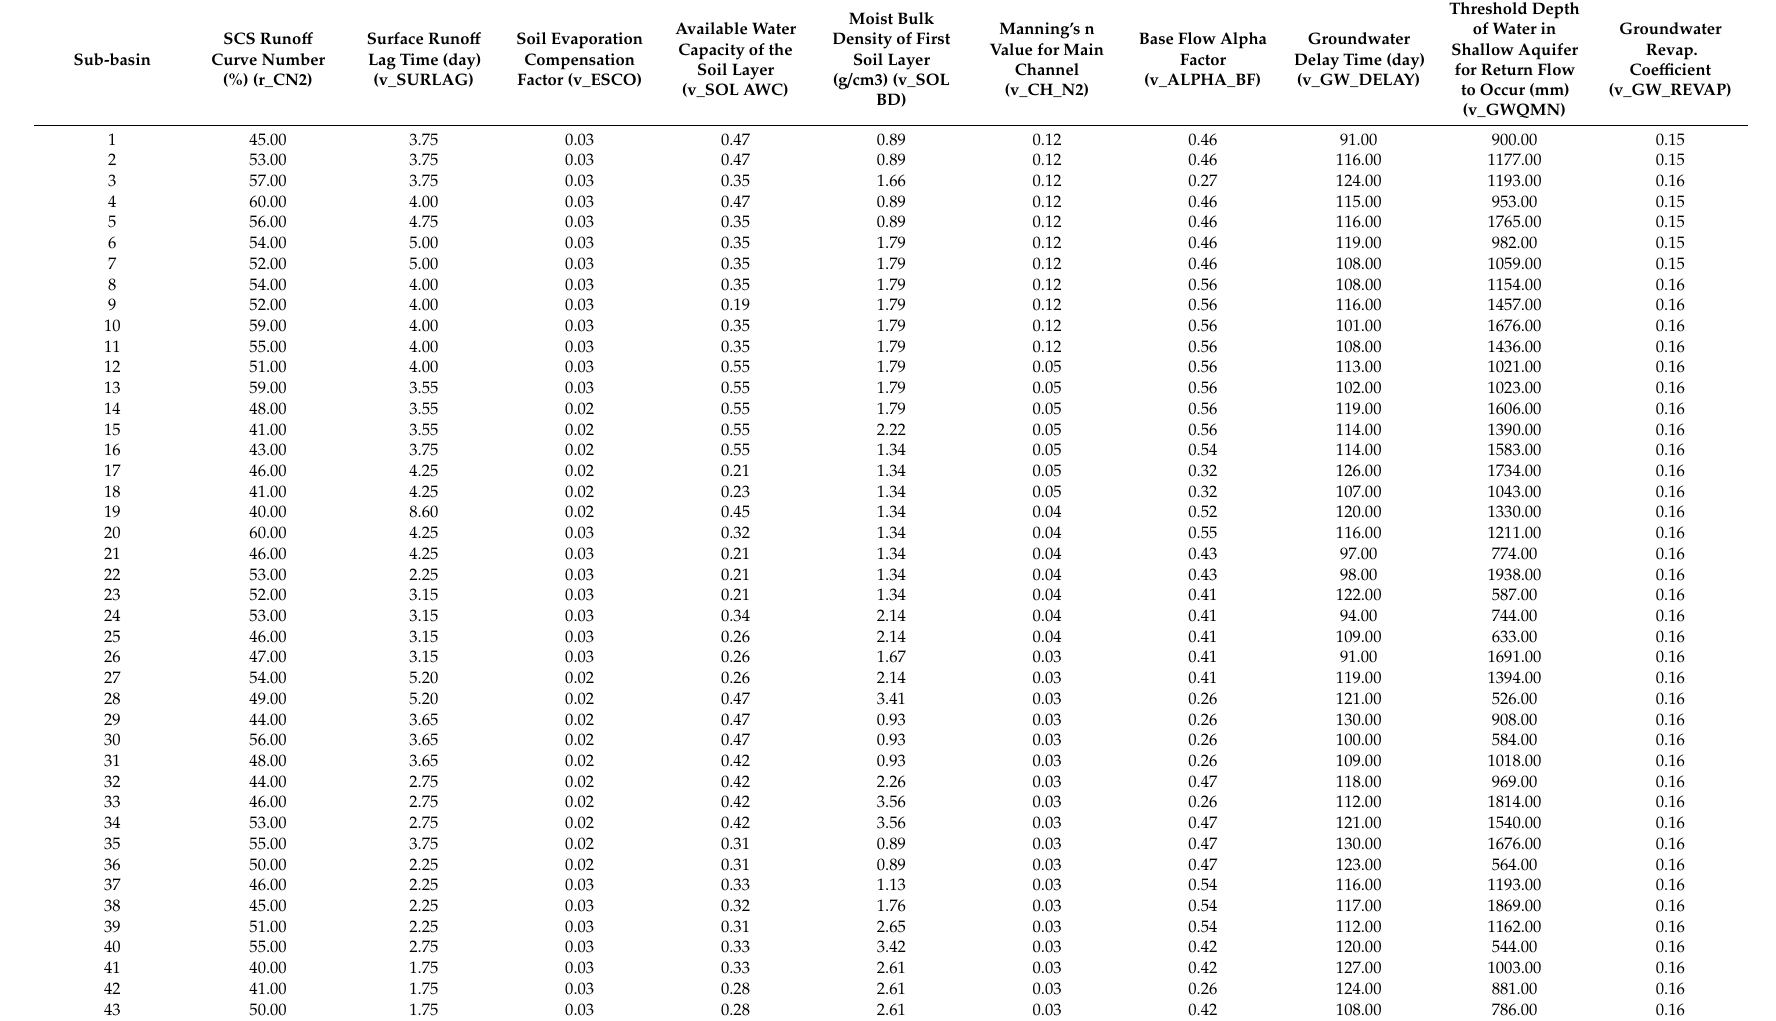
Table 8. SWAT model